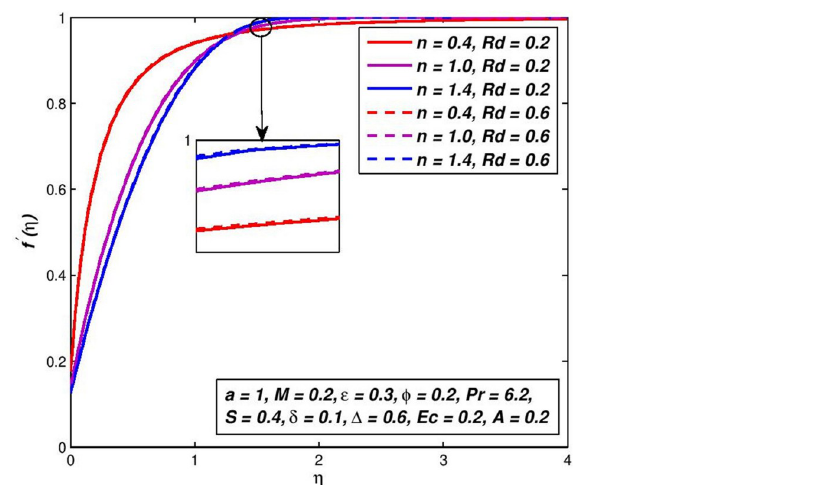
Fig 22. Effect of Rd on f 0 ( η ) for diverse n values.